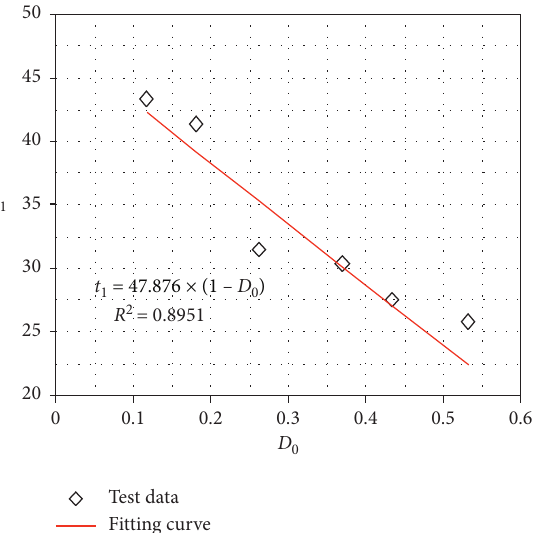
Figure 10: The relationship between t